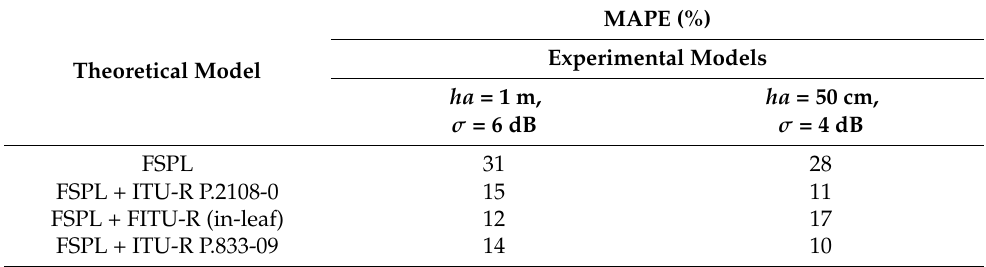
Table 9. Statistics of comparison between the theoretical FSPL model and the proposed models over water within vegetation.